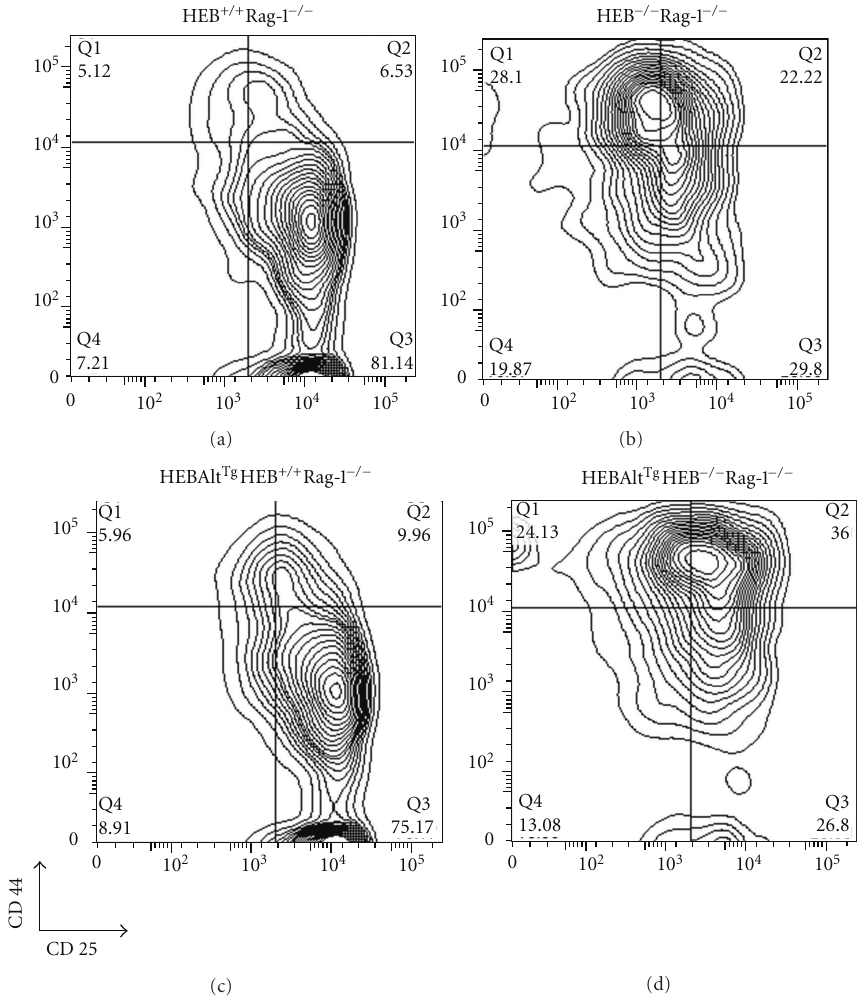
Figure 5: Developmental phenotype of HEB − / − Rag-1 − / − T-cell progenitors expressing transgenic HEBAlt. HEB + / − mice were bred with Rag- 1 − / − mice to generate HEB + / − Rag-1 − / − mice, which were timed mated to generate (a) HEB + / + Rag-1 − / − and (b) HEB − / − Rag-1 − / − embryos. Similarly, HEB + / − Rag-1 − / − mice were bred with HEBAlt Tg mice to generate HEBAlt Tg HEB + / − Rag-1 − / − mice, which were timed mated to generate (c) HEBAlt Tg HEB + / + Rag-1 − / − and (d) HEBAlt Tg HEB − / − Rag-1 − / − embryos. Fetal livers were genotyped, lineage depleted (lineage positive fraction: B cells, myeloid cells, red blood cells). Fetal liver LSK (lineage negative, Sca1 + , ckit + ) cells were sorted and cultured on OP9- DL1 for 7 days to allow developmental progression to the DN3 stage. At day 7, lymphocytes were gated on the CD45 + CD4 − CD8 − fraction and sorted for the DN3 cells (CD44 − CD25 + ), which were cultured on fresh OP9-DL1 stroma with 5ng/mL IL7 and Flt3L. Four days later, whole cell cultures were analysed by flow cytometry. All plots were gated on the CD45 + CD4 − CD8 −